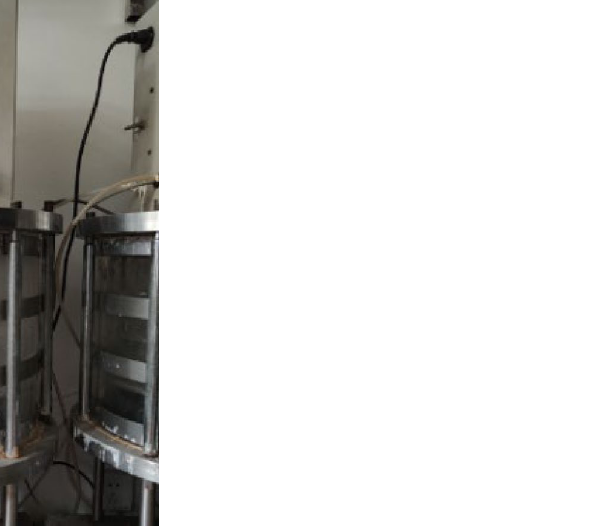
Figure 2. YRK-1 rock dissolution